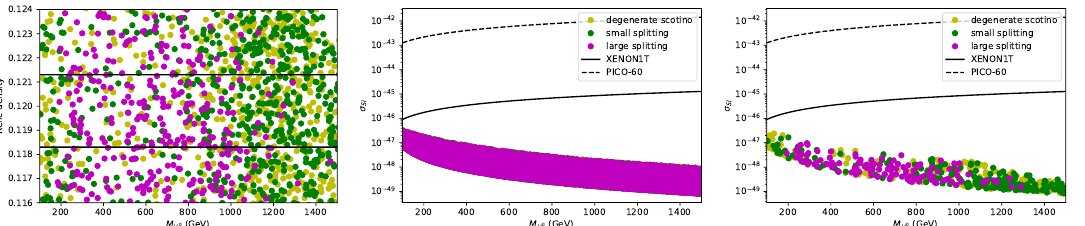
Figure 1 . (Left): relic density vs. M with horizontal black lines showing 1 σ range Ω obs h 2 . H 0 1 DM (Middle): direct detection cross section plotted against M , along with bounds from XENON1T H 0 1 (in black solid) and PICO experiments (in black dashed). As the direct detection cross sections are independent of scotino masses, all the three cases overlap. (Right): direct detection cross section plotted against M , with points satisfied by Ω obs within 1 σ . Different colours correspond H 0 1 to different scotino mass hierarchy with Case (i) (greenish yellow), Case (ii) (green) and Case (iii) (magenta) given in table 3.